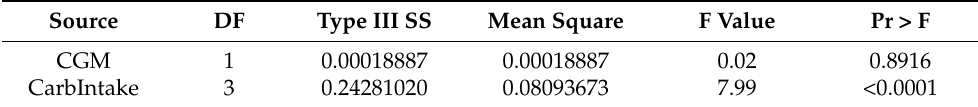
Table A8. Log A1C < 1.95% with CGM and CarbIntake as independent variables.